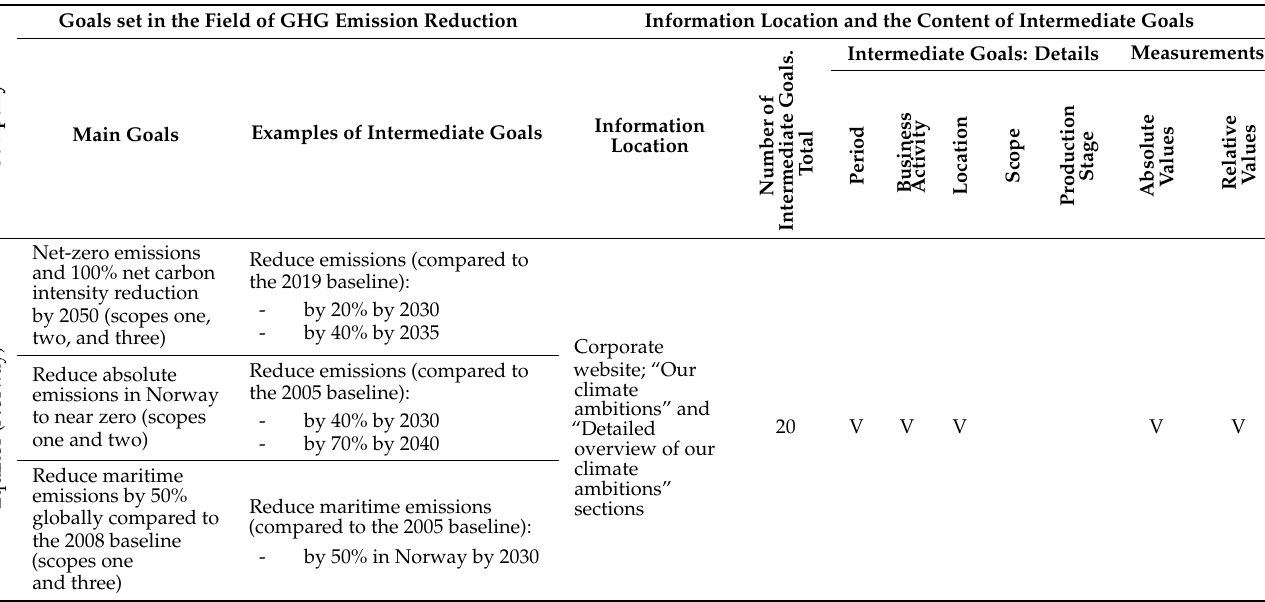
Table 1. Oil and gas companies under study and their main and intermediate goals in relation to carbon neutrality (as of